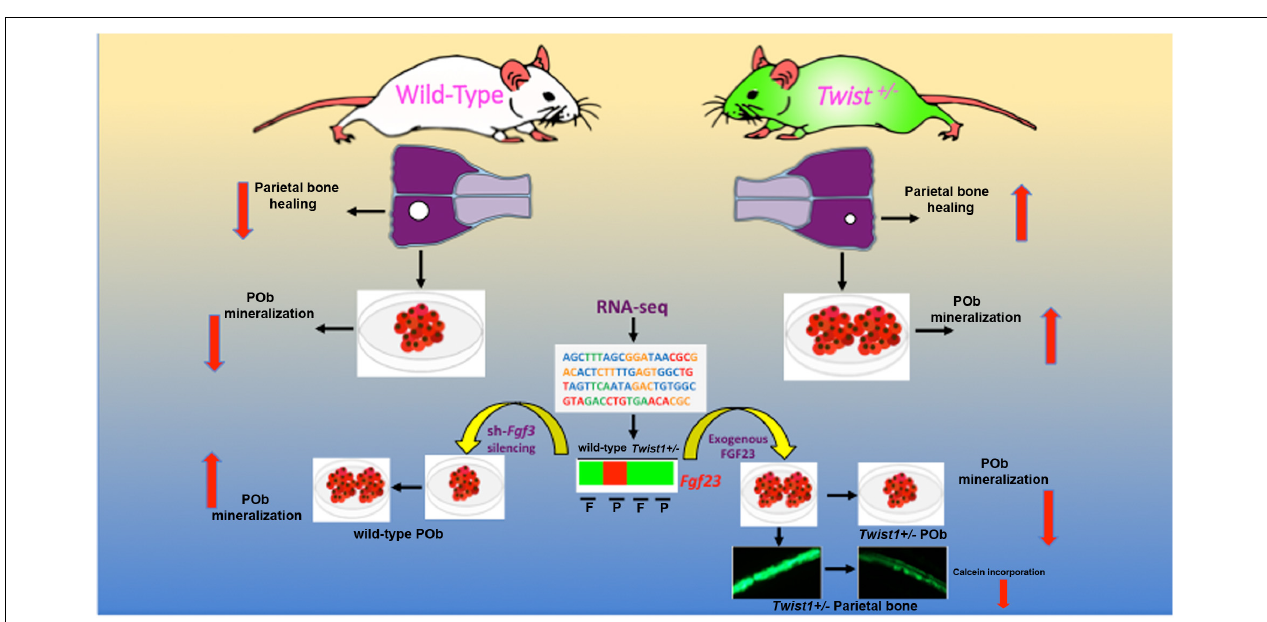
FIGURE 7 | Twist1- haploinsufficiency- Fgf23 -downregulation axis. Schematic representation of the molecular mechanism mediating the effect of Twist1 haploinsufficiency in enhancing the osteoskeletal ability of mesoderm-derived parietal bone via downregulation of